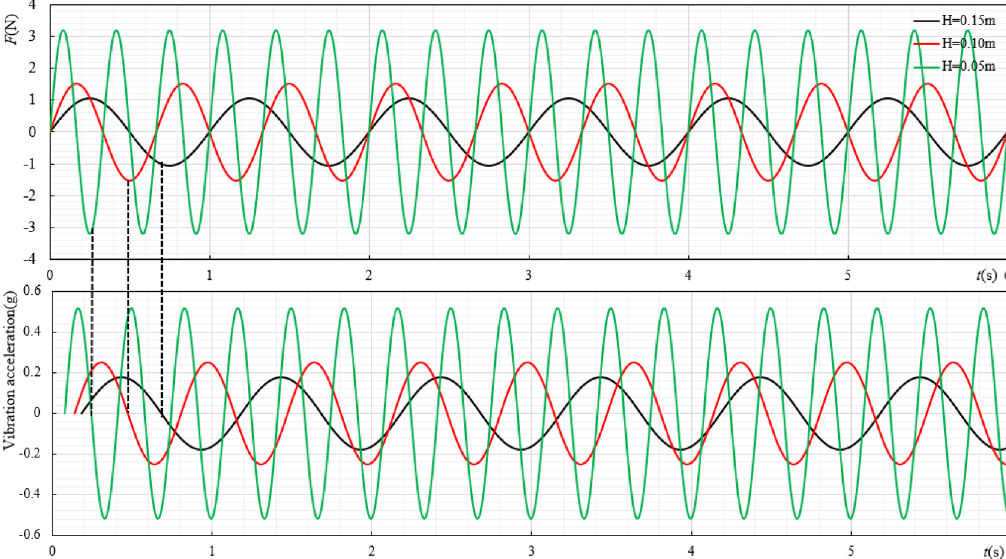
Figure 3. The size of the ore bin is 100mm × 50mm , the water depth is 1.5 m and f 0.05 = 3Hz , f 0.1 = 1.5Hz , f 0.15 = 1Hz .The variation law of ore bin force and acceleration under different excitation